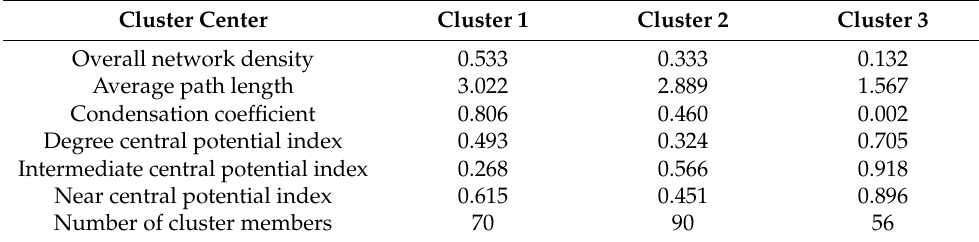
Table 3. Clustering analysis of network structure